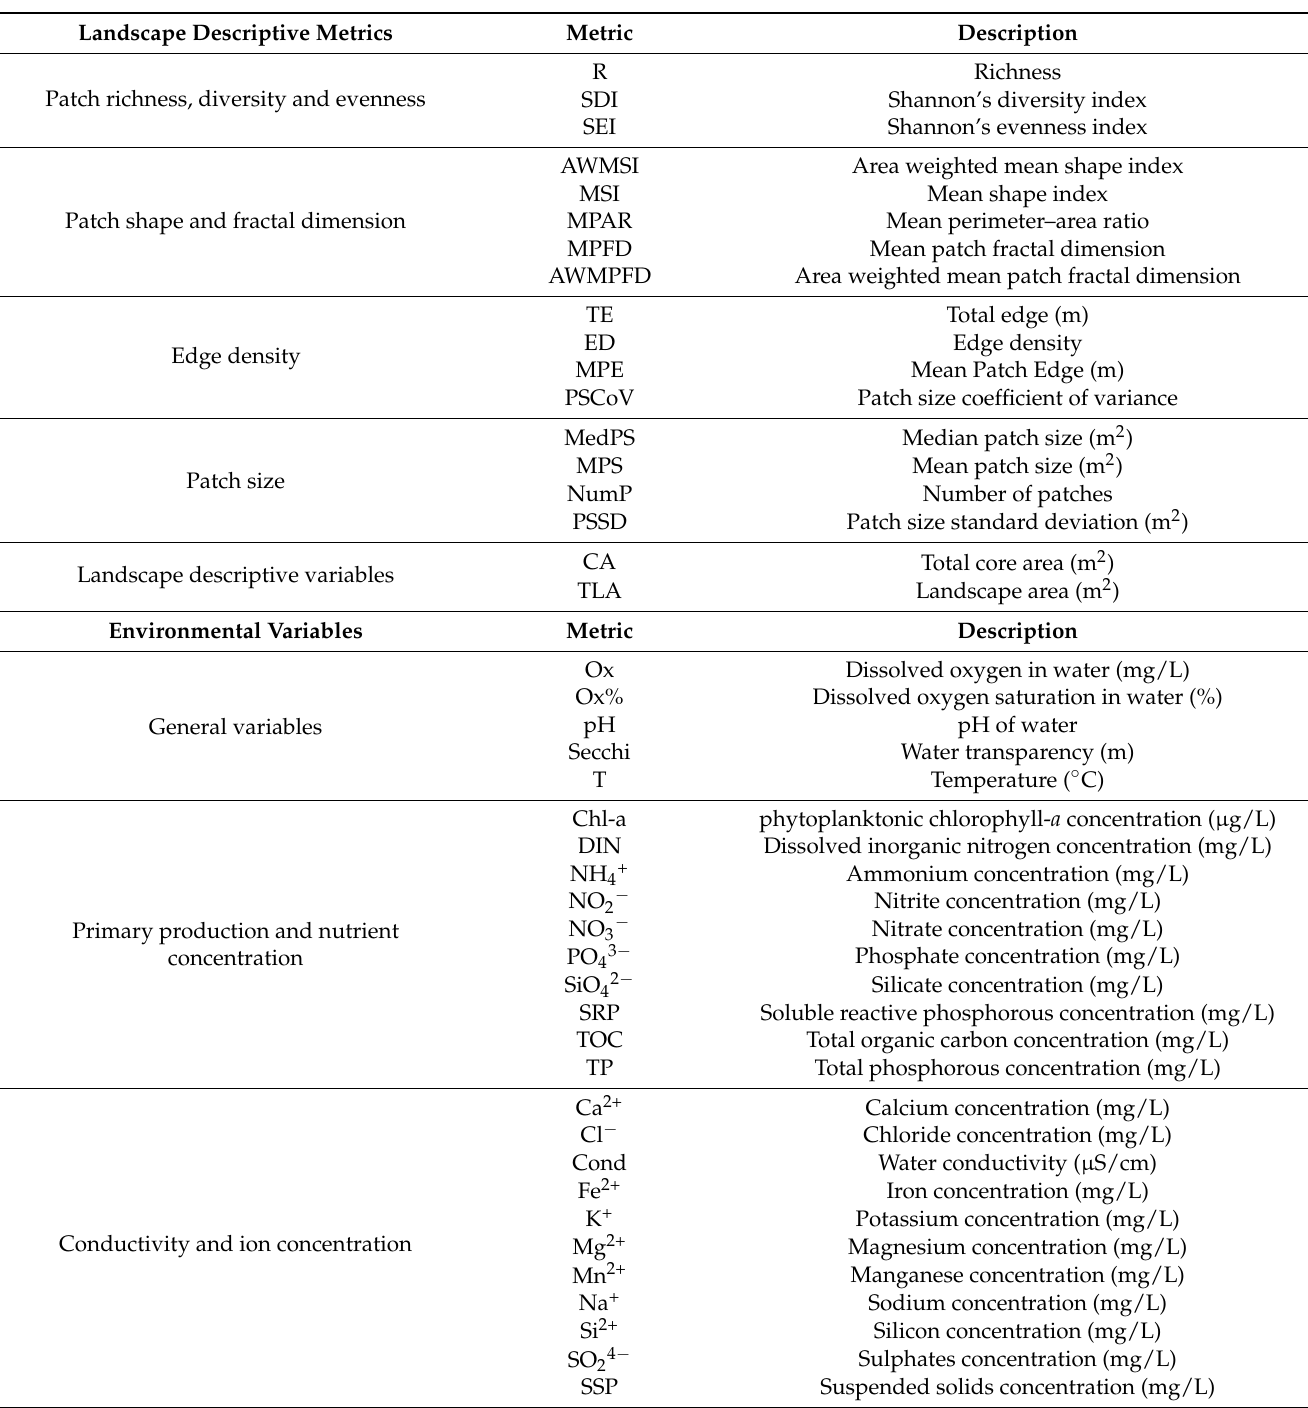
Table 2. Landscape descriptive metrics computed from a land-use cartographic database [109] and environmental variables considered in